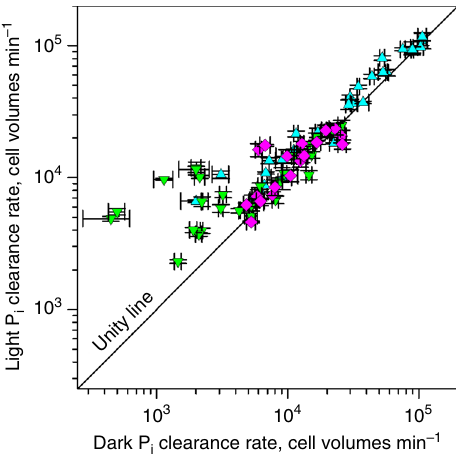
Fig. 9 Comparison of P i clearance rates of oceanic cells in the light versus dark. Comparison of P i clearance rates in cell volume equivalents of oceanic SAR11 (turquoise triangles, n = 28), Prochlorococcus (green triangles, n = 32) and Synechococcus (pink diamonds, n = 19) at ambient P i concentrations. Equivalents of cell volumes cleared of P i per minute were used to negate the bacterial size differences. Symbols present mean values of four sorting replicates of the paired light vs. dark experiments; error bars indicate corresponding SD. Source data are provided as a Source Data fi le. Values above the unity line indicate light